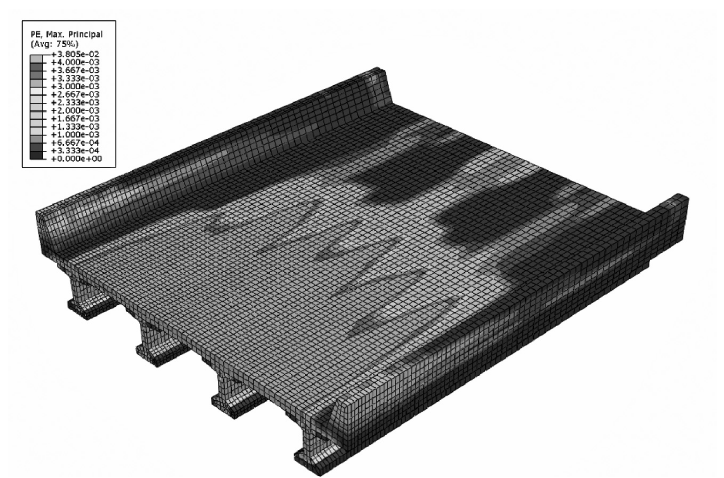
Fig. 27. Maximum principal plastic strain, blast below. Top view.